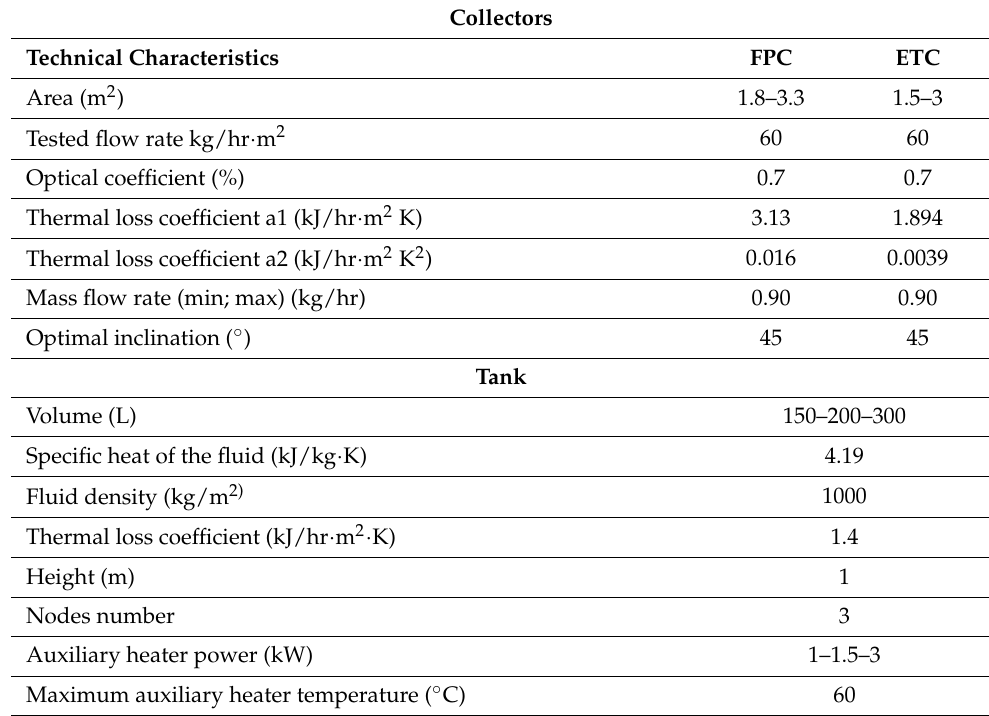
Figure 6. The flowchart of individual solar water heater (SWH) system. Table 7. Technical characteristic of collectors and tanks (individual SWH).